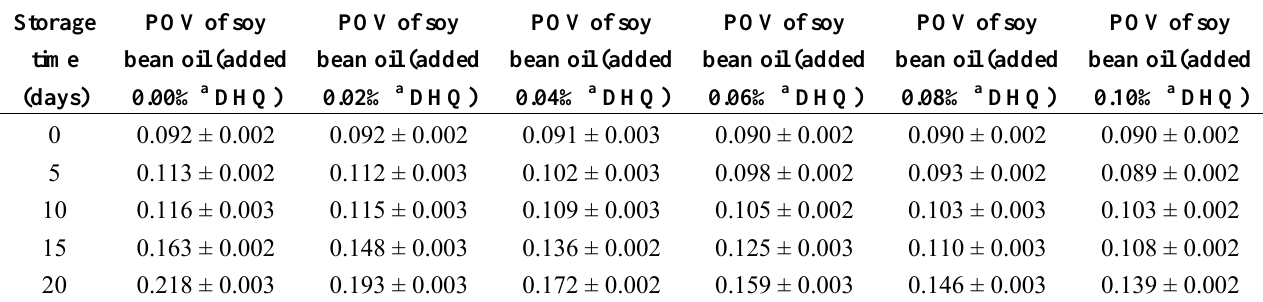
Table 2. Peroxide Value (POV) of soy bean oil after addition of DHQ during storage at 25 °C.